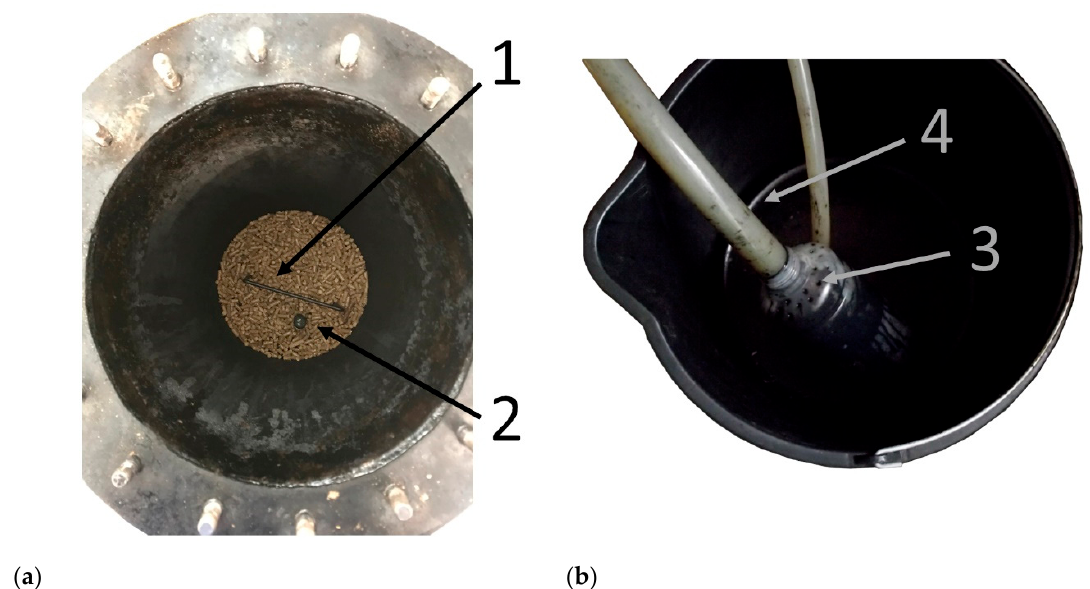
Figure 3. ( a ) Loading of pellets into the reactor, ( b ) Protection against air ingress into the reactor. Legend: (1) grille handle, (2) thermocouple pocket, (3) bottle with water and holes in the cover, (4) the terminal of exhaust torrgas pipe.